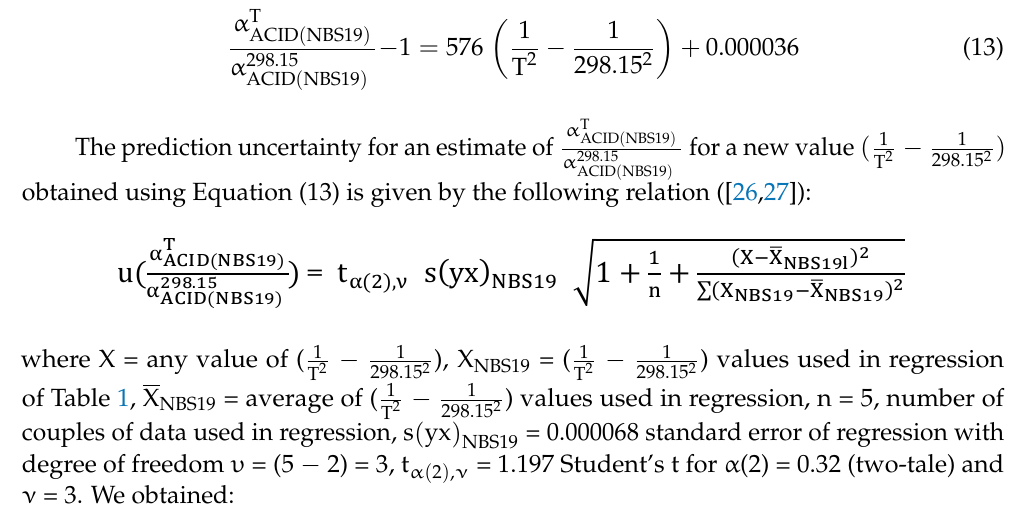
couples of data used in regression, s ( yx )